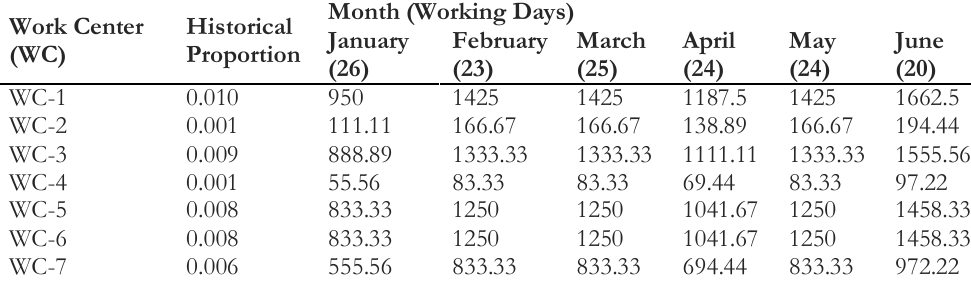
Table 9. Required capacity for IGB using Bill of Labor Approach